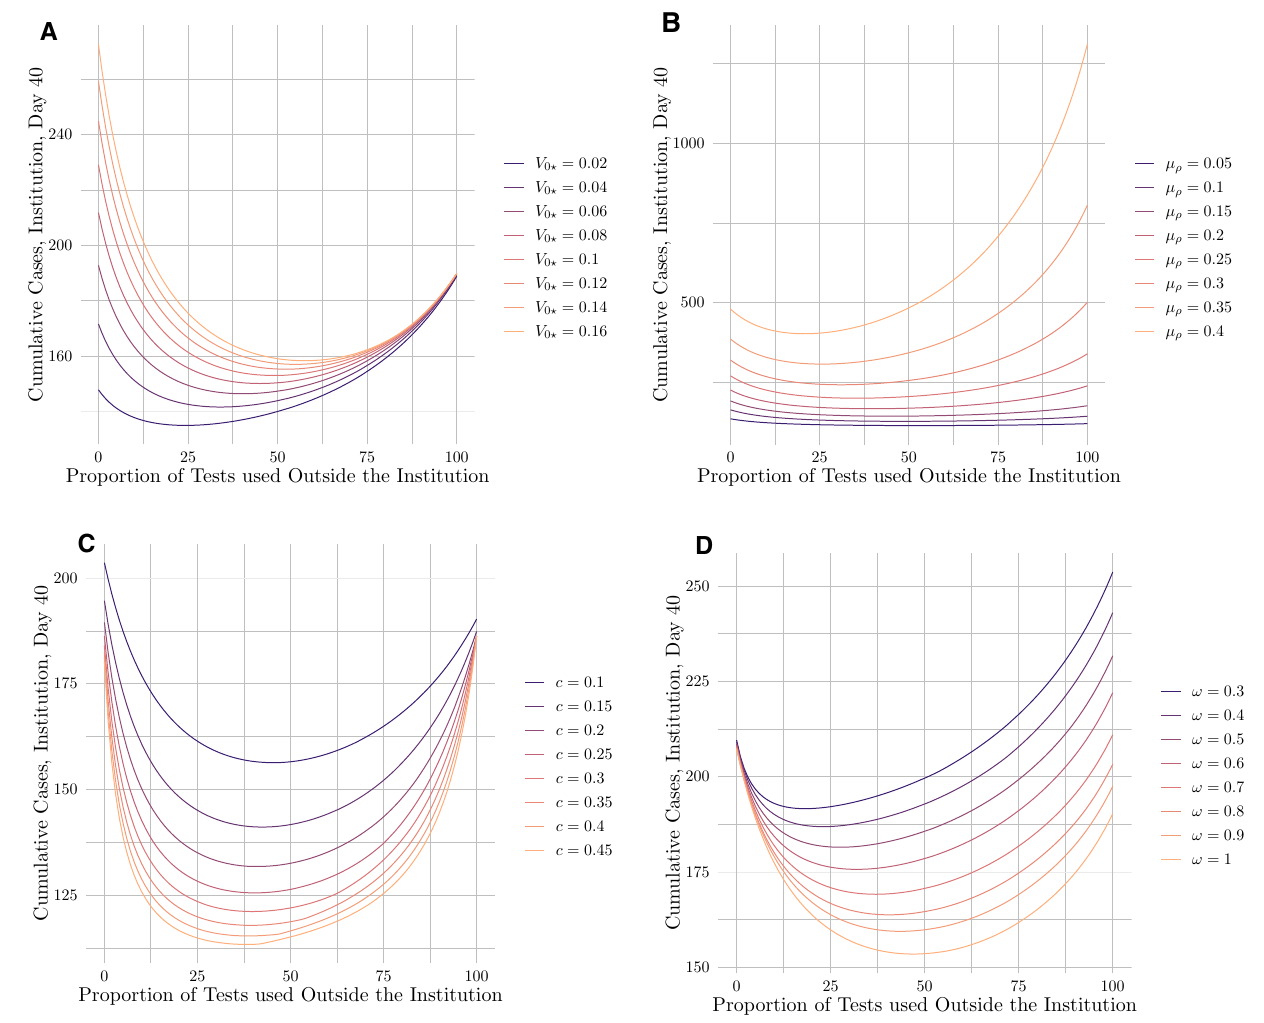
Figure 3. Cumulative cases on day 40 as a function of the proportion of tests deployed to the periphery under different values of ( A ) the initial prevalence in the periphery, V 0 ∗ ; ( B ) the secondary attack rate among institution members, µ ρ ; ( C ) the tests-per-person-per-day ratio, c , and ( D ) the proportion of contacts traced ω